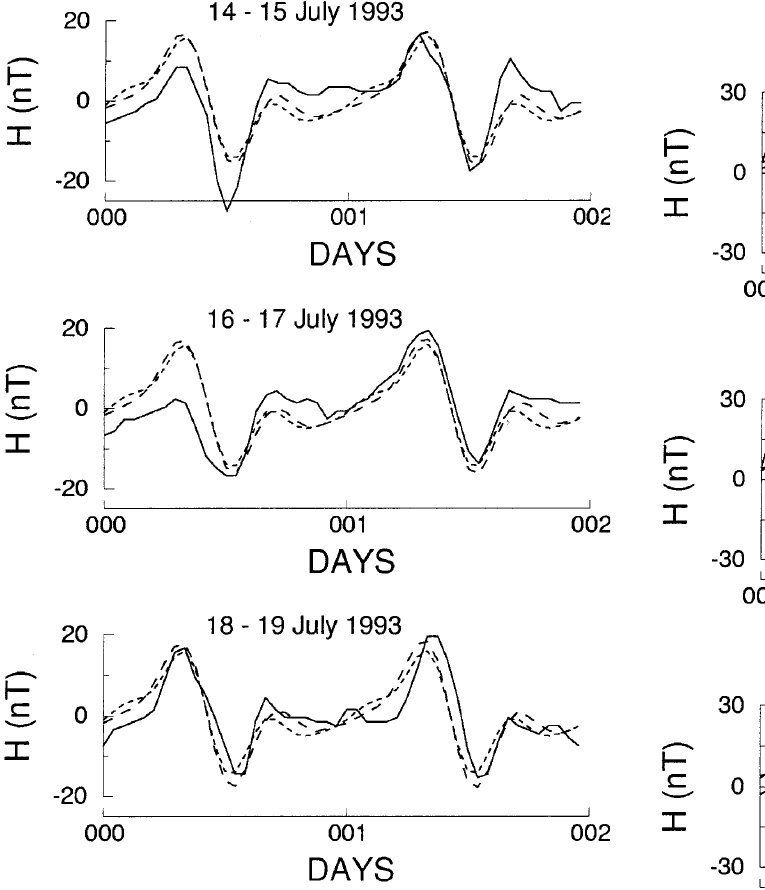
Fig. 6. A comparison of the observed ( solid curves ), HA determined ( short dashed curves ), and ANN determined ( long dashed curves ) daily variations. The ANN was trained using the H-component data from three stations, namely HER, HBK, and TSU, for the 12 year period 1978 to 1989. The curves shown are for a sequence of six very quiet days, where all K indices were either 0 or 1, for the H-component at HER for the interval 14–19 July 1993